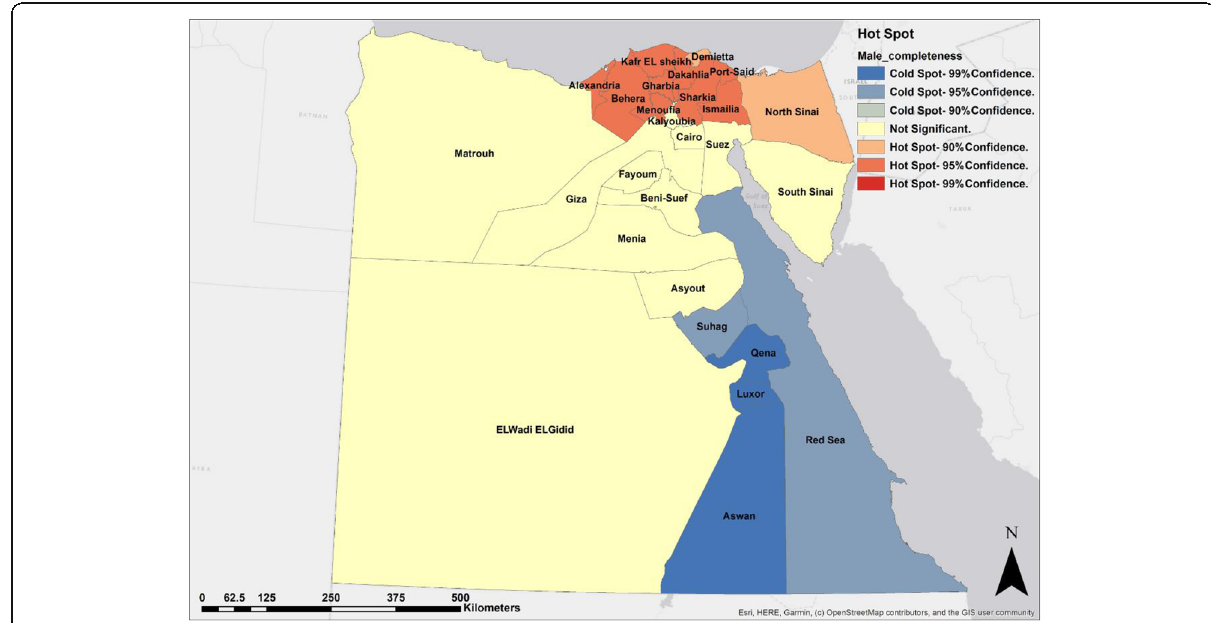
Fig. 3 Hot spots of the completeness of male death registration, Egypt,